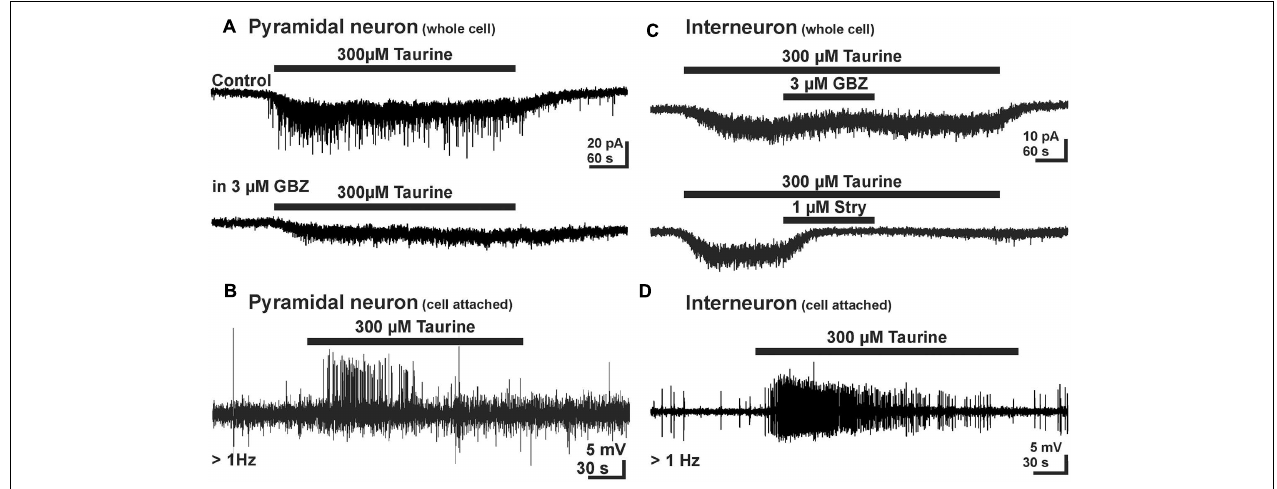
FIGURE 4 | Effect of taurine on GABAergic networks in early postnatal mouse neocortex. (A) In pyramidal neurons taurine induced a tonic inward current and increased the frequency of GBZ-sensitive GABAergic PSCs. (B) Cell-attached recordings demonstrating that GABAergic PSCs enhance action potential frequency, suggesting that the taurine-induced GABAergic PSCs are excitatory. (C) In GABAergic interneurons taurine induced an inward-current that was relatively insensitive to GBZ, but suppressed by strychnine, indicating that taurine acts mainly via glycine receptors in this cell type. (D) Cell-attached recordings from GABAergic interneurons demonstrate that the taurine-induced inward current enhances action potential frequency, suggesting that the taurine is an excitatory neuromodulator in immature interneurons (with permission from Sava et al., 2014).